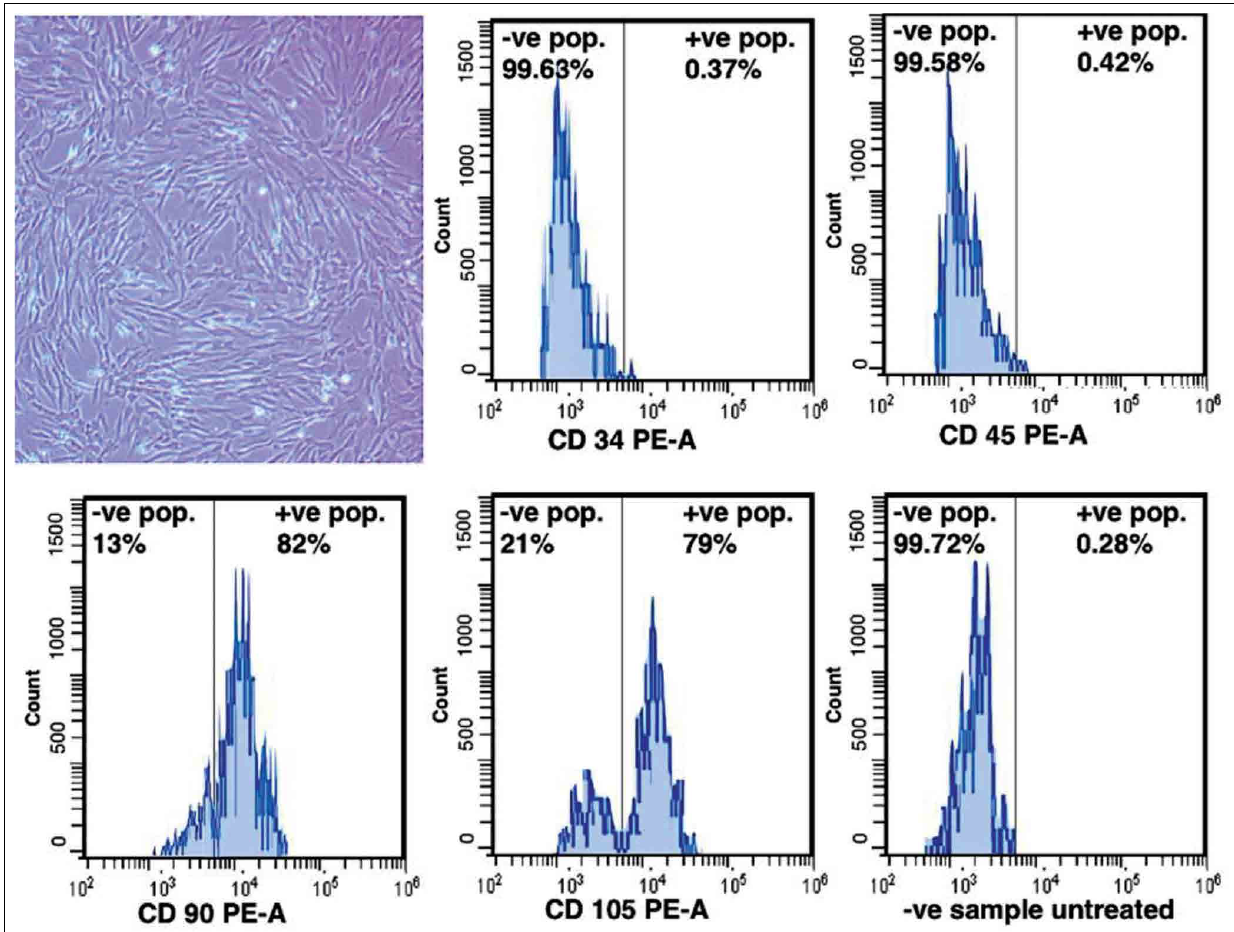
Figure-3: Isolation and phenotypic analysis of bone marrow mesenchymal stem cells (BMMSCs). (a) Photomicrograph of cultured BMMSCs reached 80% confluence showing spindle and stellate shaped appearance 10×. Phenotypic analysis showed that cultured BMMSCs positively expressed CD90 (82%) and CD105 (79%) and negatively expressed CD34 and CD45 antibodies staining. Negative sample untreated showed 0.28 +ve population and 98.52 –ve